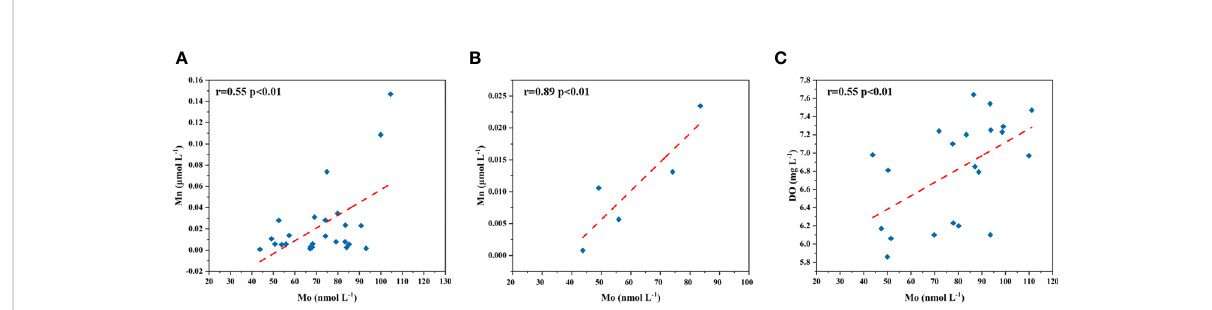
FIGURE 7 Correlations between dMo and dMn concentrations in surface seawaters of the BS and YS (A) and that of the BS (B) , and correlation between DO and dMo concentrations in bottom seawaters of the YS (C)